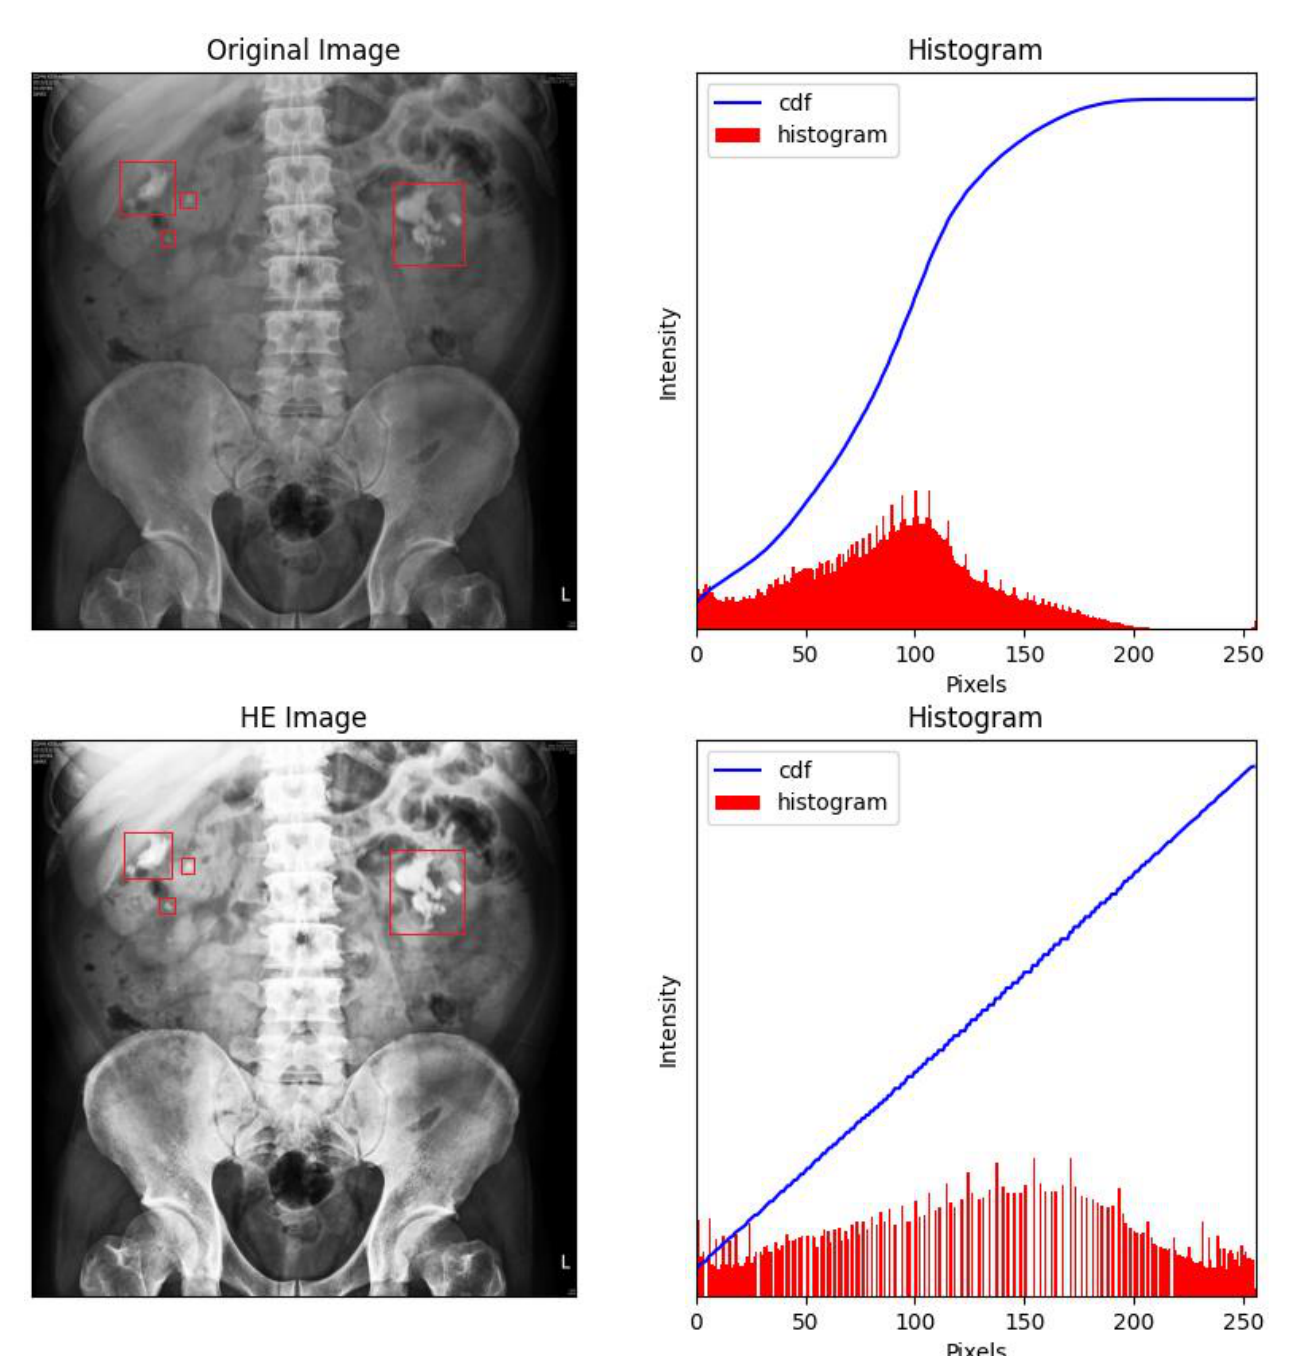
Figure 5. Many areas were overexposed in the HE-processed images, especially around dense tissue such as bone. The renal stones were labelled with red frames by the experts.